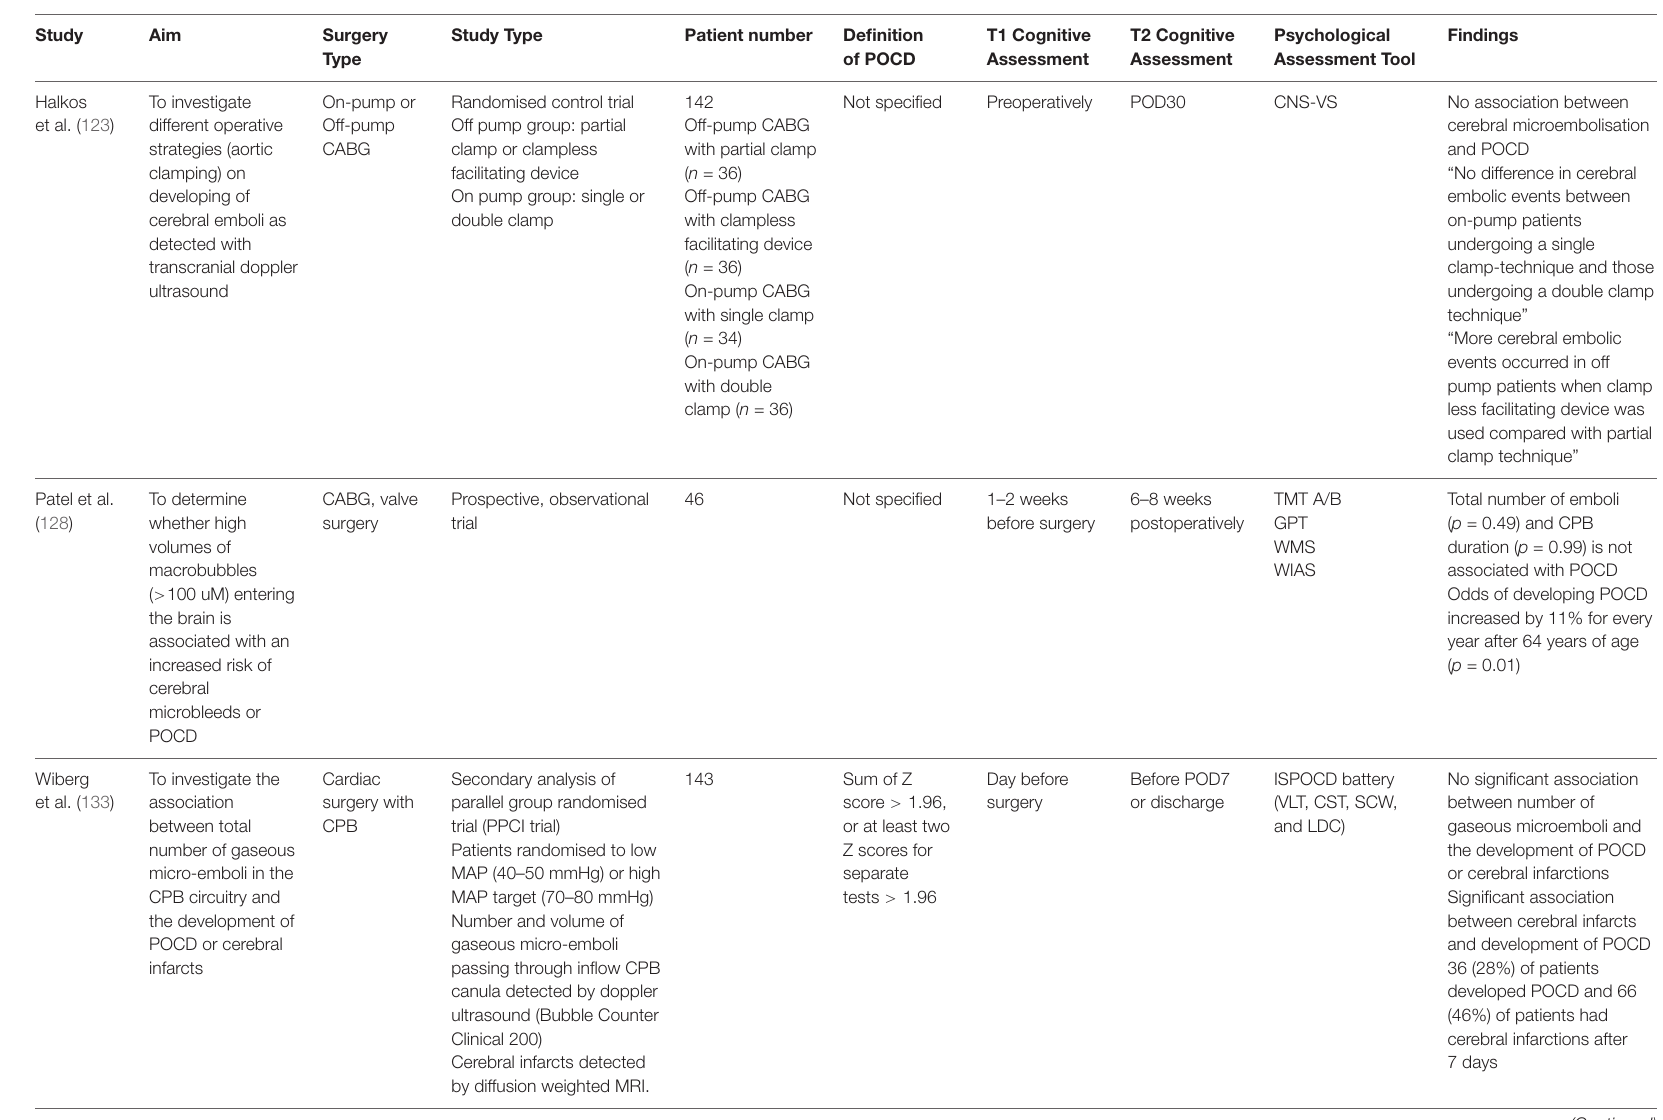
TABLE 5 | Studies analysing microemboli and